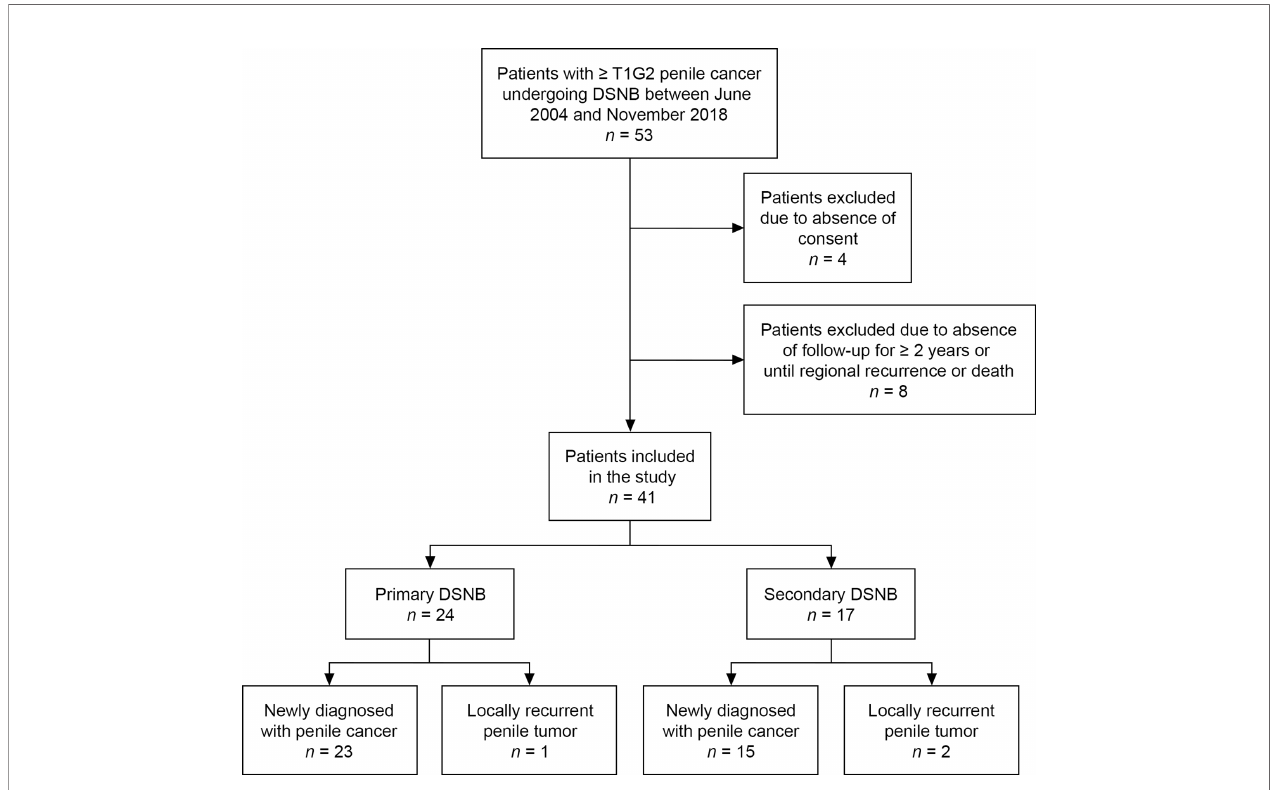
FIGURE 1 | Flowchart of included and excluded